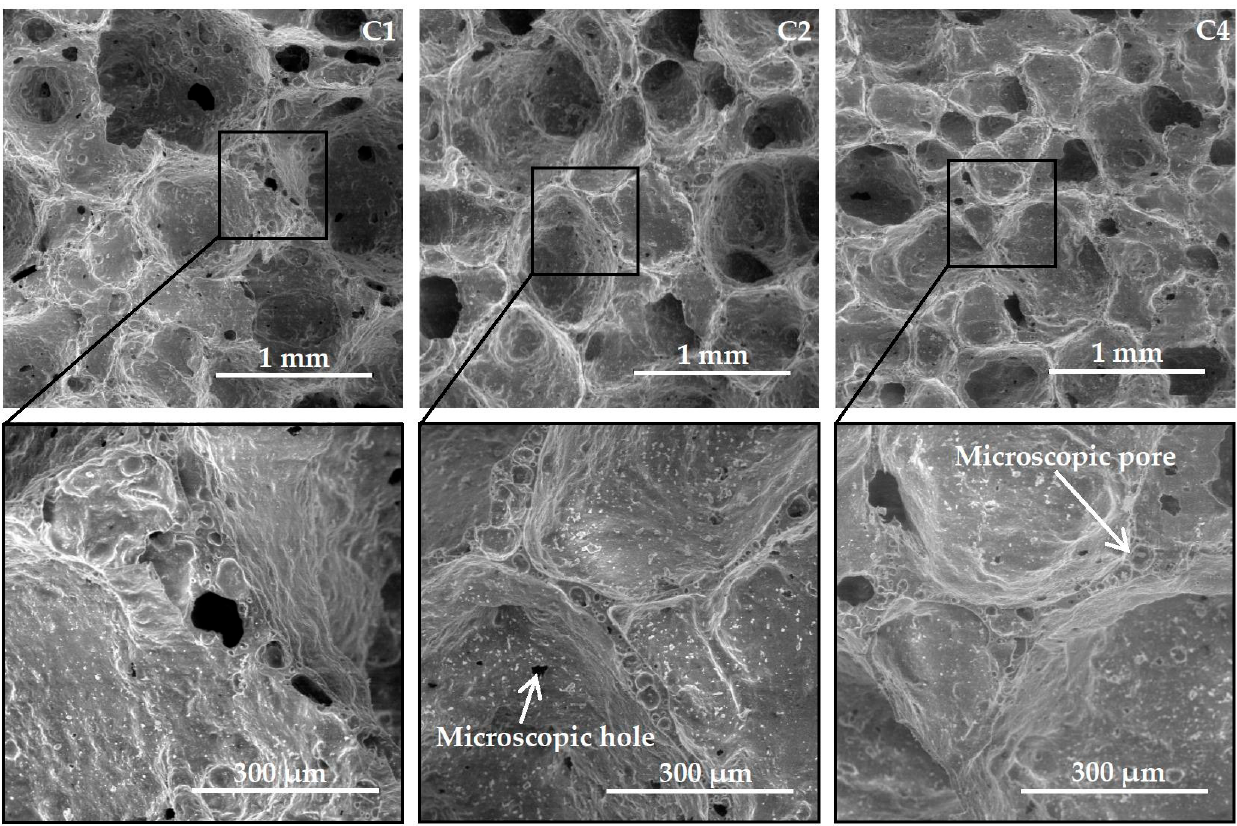
Figure 4. SEM micrographs of samples.